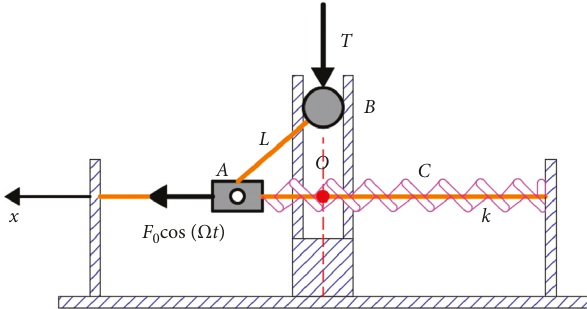
Figure 1: Simplified oscillator of a linkage-slider structure.